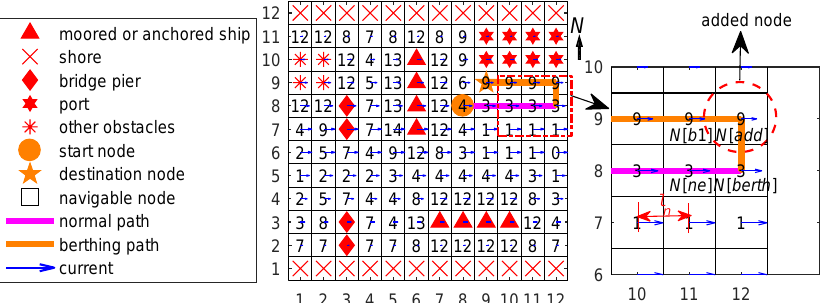
Figure 7. The combined path to deal with a sharp